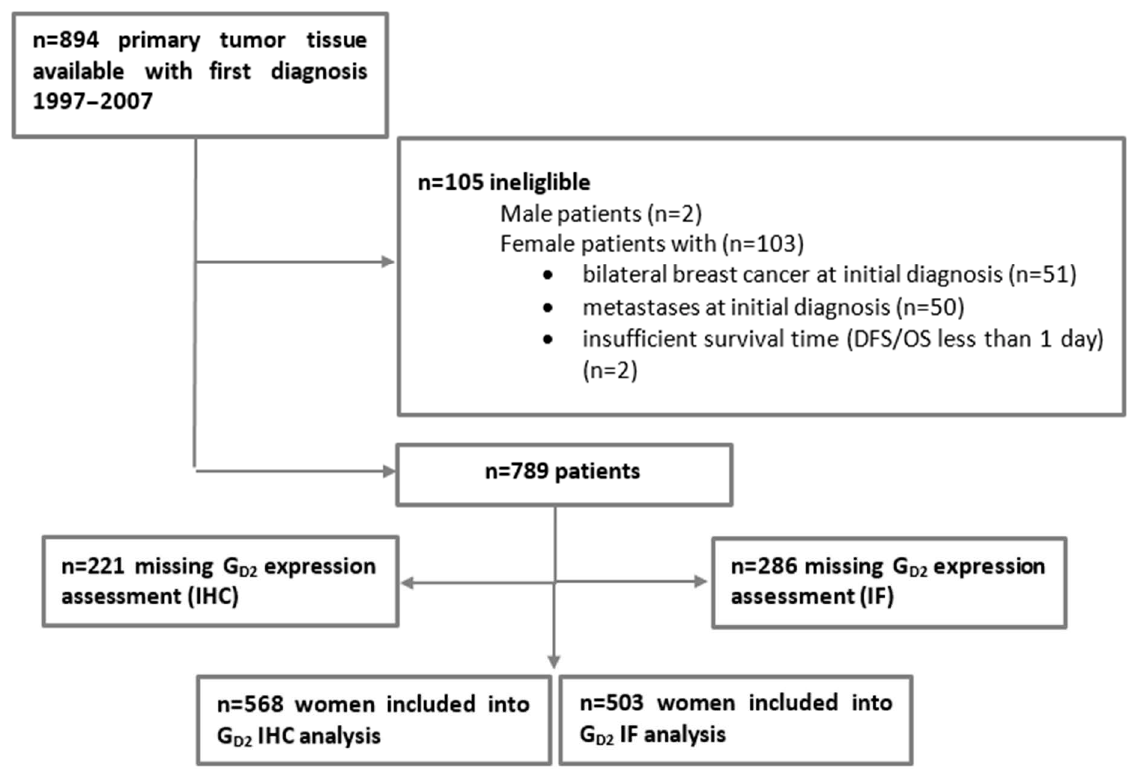
Figure 1. Patient selection and exclusion criteria. DFS, disease free-survival; IF, immunofluorescence; IHC, immunohisto- chemistry; OS, overall survival.